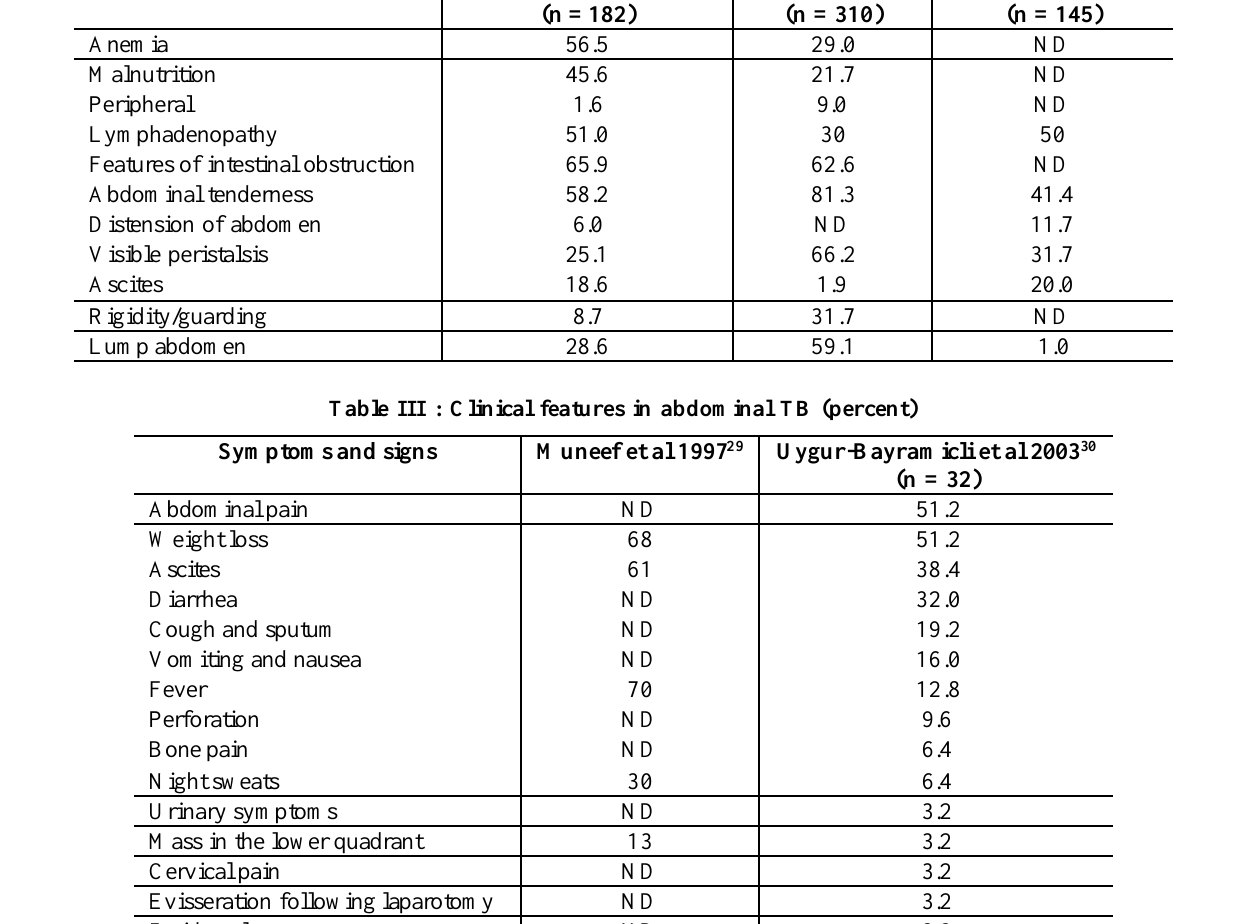
Table II : Physical signs at presentation in Indian patients with abdominal tuberculosis Variable